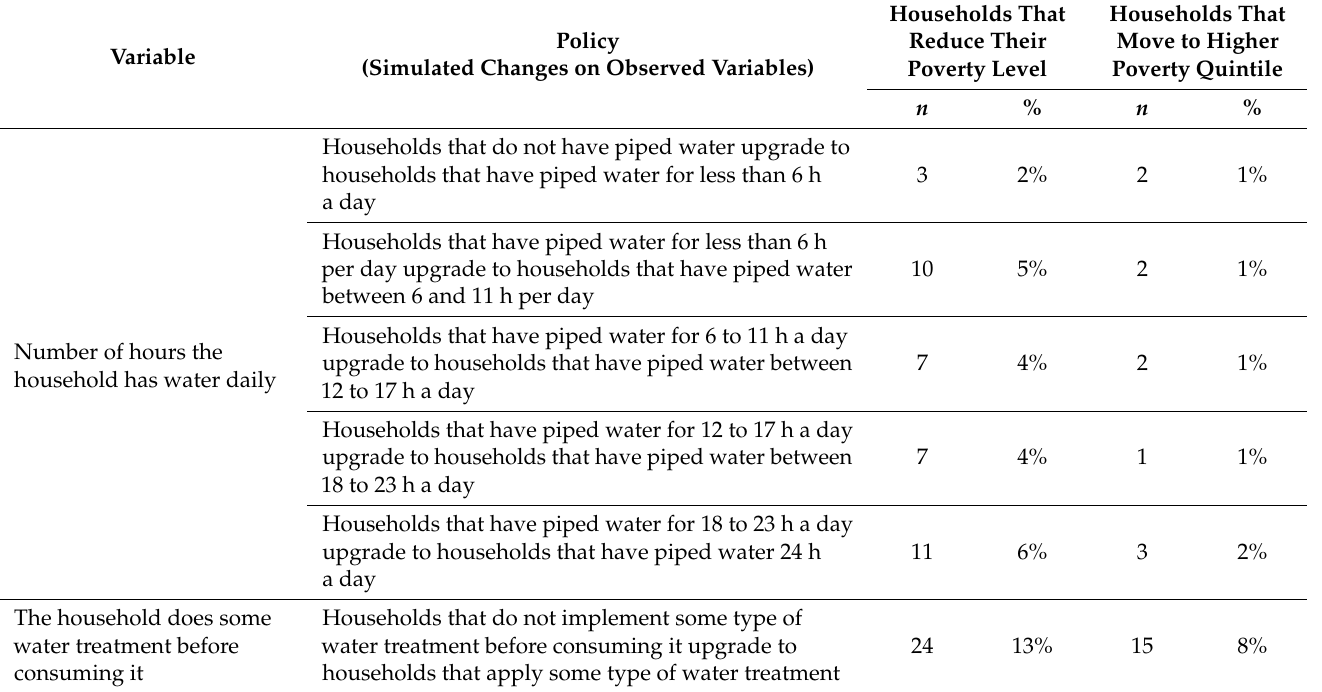
Table 11. Effect of water policies on the level of multidimensional poverty in the city of Tupiza. Policy Variable (Simulated Changes on Observed Variables)